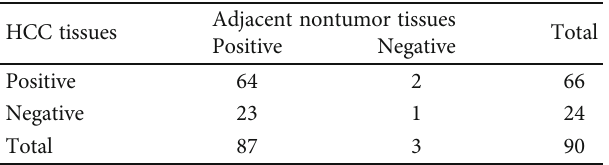
Table 1: TSPAN9 expression in paired HCC tissues and adjacent nontumor